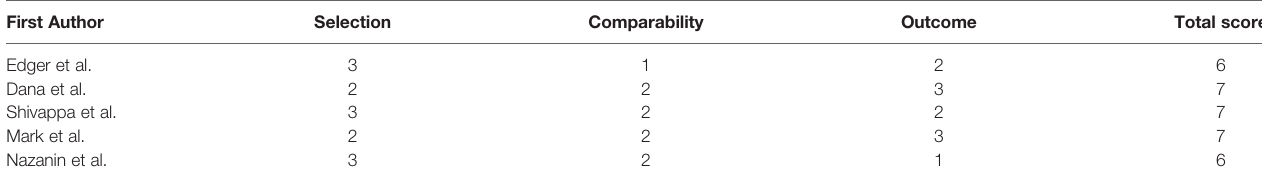
TABLE 2 | Methodological quality assessment scores of the included studies.